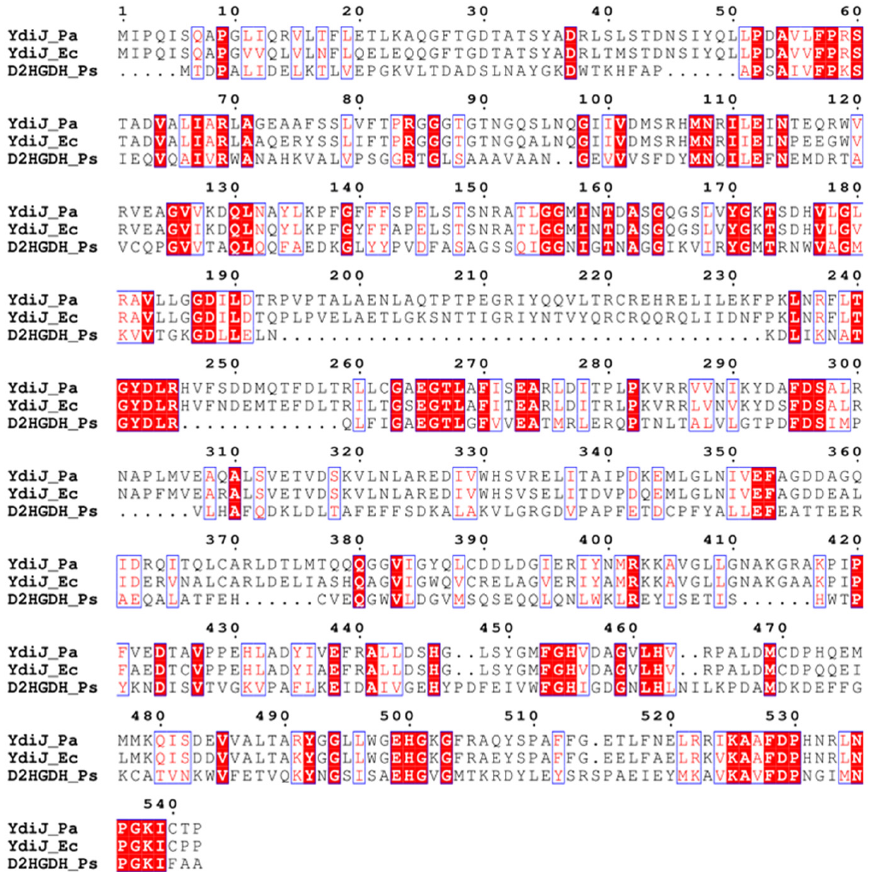
Figure 3. Domain structure of YdiJ of P. ananatis (Pa) and E. coli (Ec) and D2HGDH of P. stutzeri A1501 (Ps).